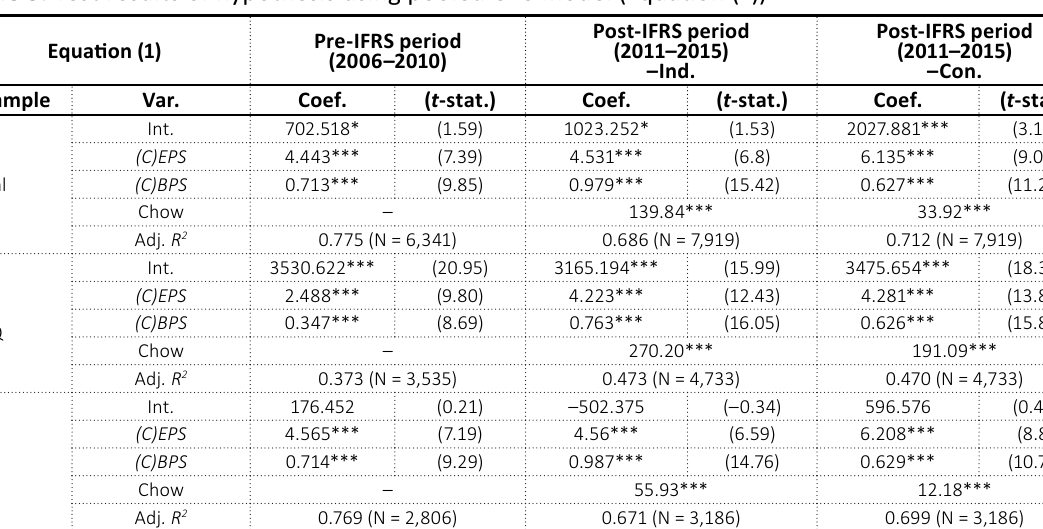
Table 2. Pearson & Spearman Correlation Matrix ( n = 14,260) Variables Pre-IFRS period